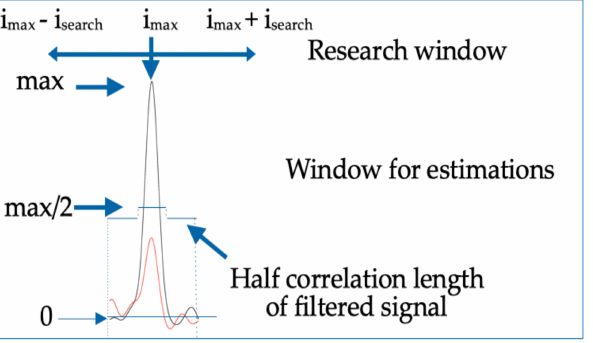
Figure 16. Summary of the process of determining the averaging window on the ν Off - frequency